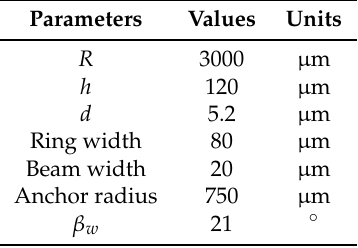
Table 1. Parameters of the MRR.